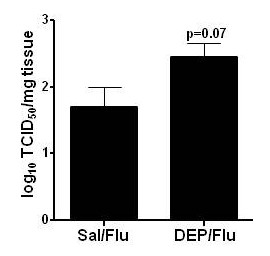
Effects of exposure to DEP on lung viral titers. Whole lungs from animals infected with influenza (Sal/Flu and DEP/Flu) obtained 18 hours post-infection were homogenized and analyzed for lung viral titers. Values shown are mean tissue culture infectious dose normalized to tissue weight (TCID50/mg tissue).